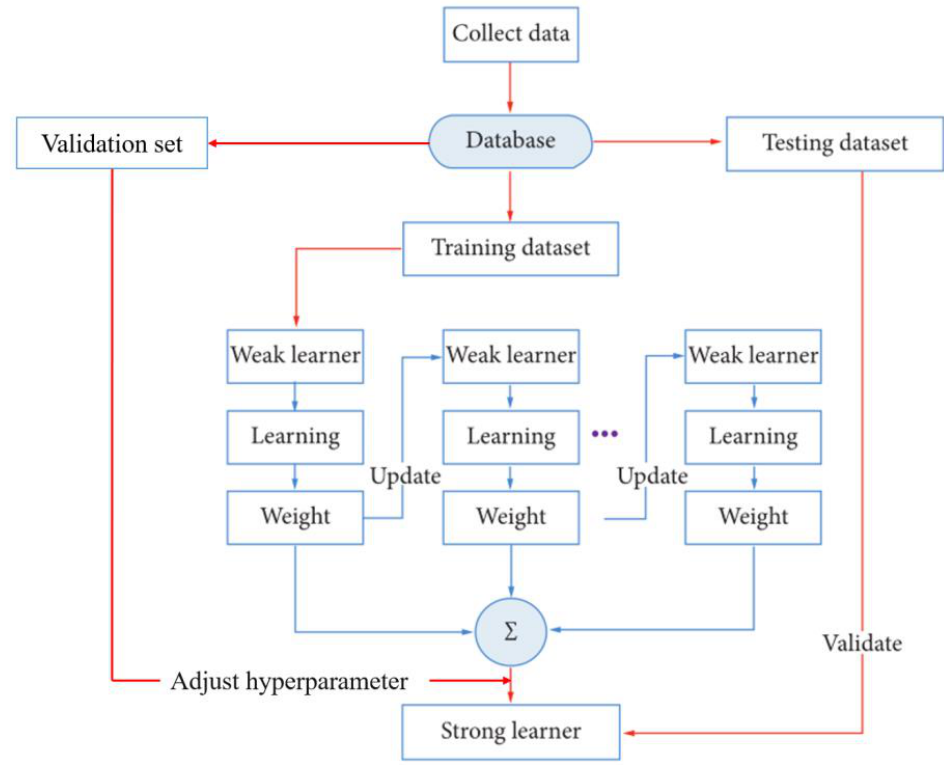
Figure 9. Flowchart of the implementation process of GBRT [67].